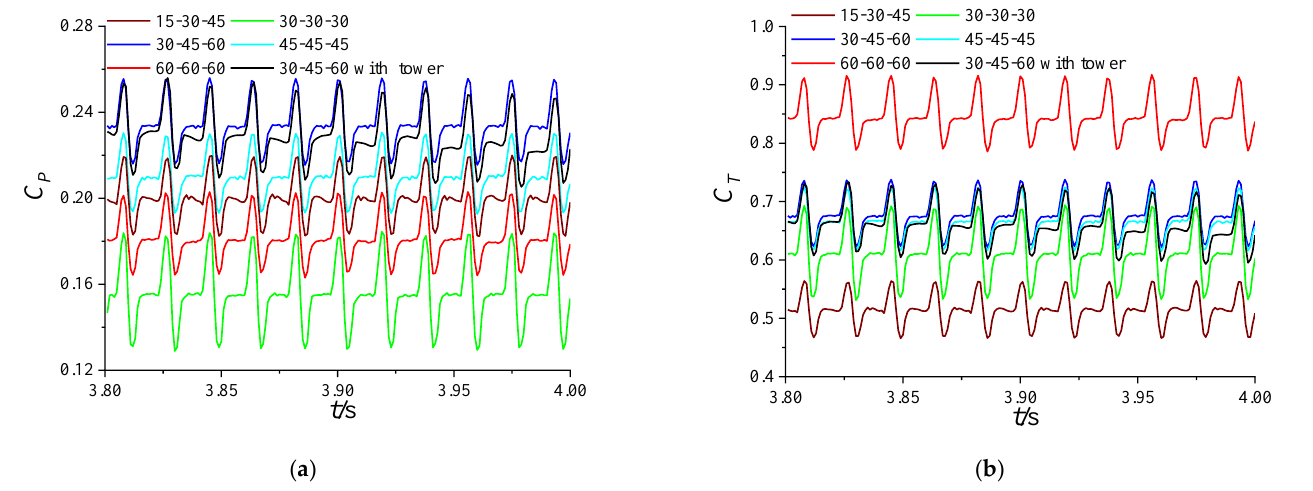
C and C for the five ASWT rotors at T S R =1.5: ( a ) Figure 12. Time histories of Figure 12. Time histories of C P and C T for the five ASWT rotors at TSR = 1.5: ( a ) C P ; ( b ) C T T P